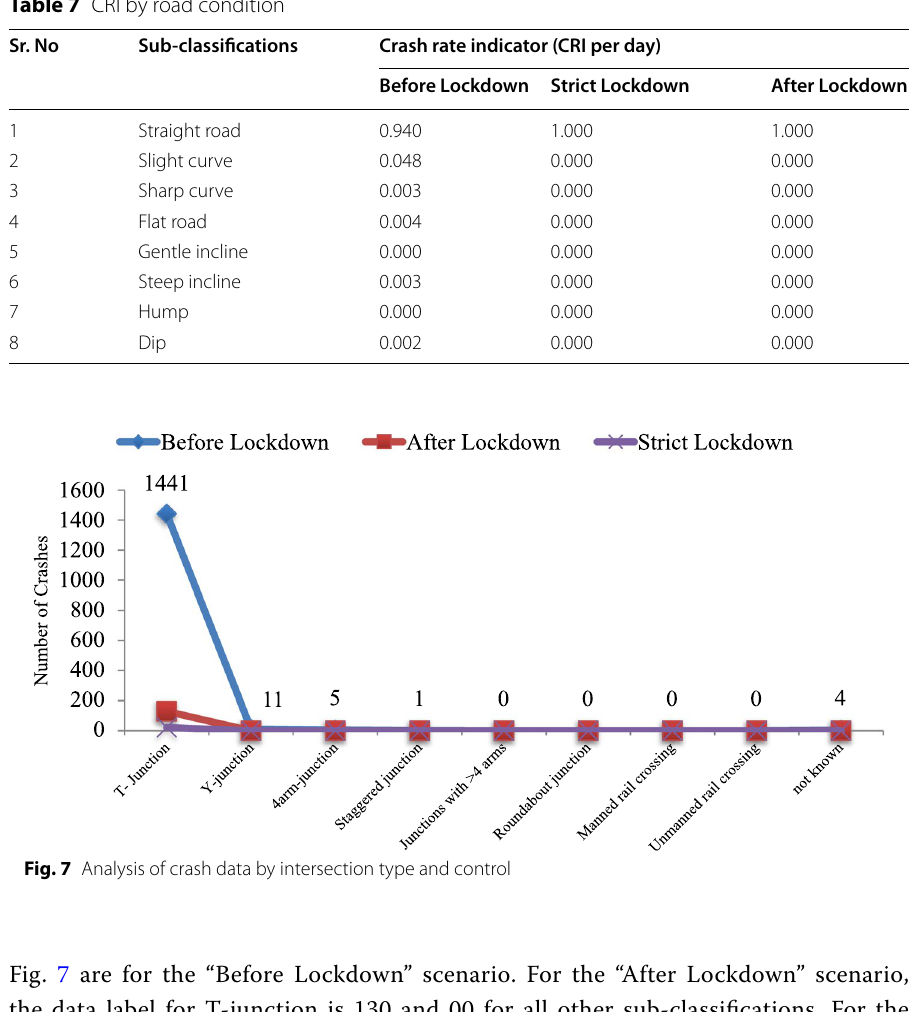
Fig. 7 are for the “Before Lockdown” scenario. For the “After Lockdown” scenario, the data label for T-junction is 130 and 00 for all other sub-classifications. For the